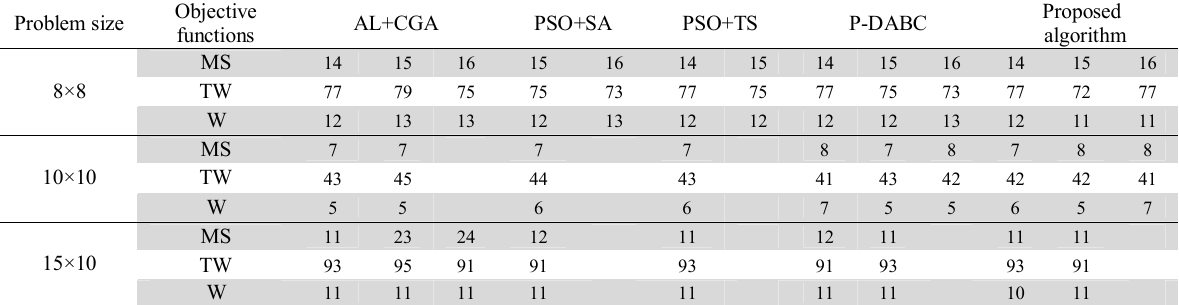
Comparison results between proposed method and other algorithms Problem